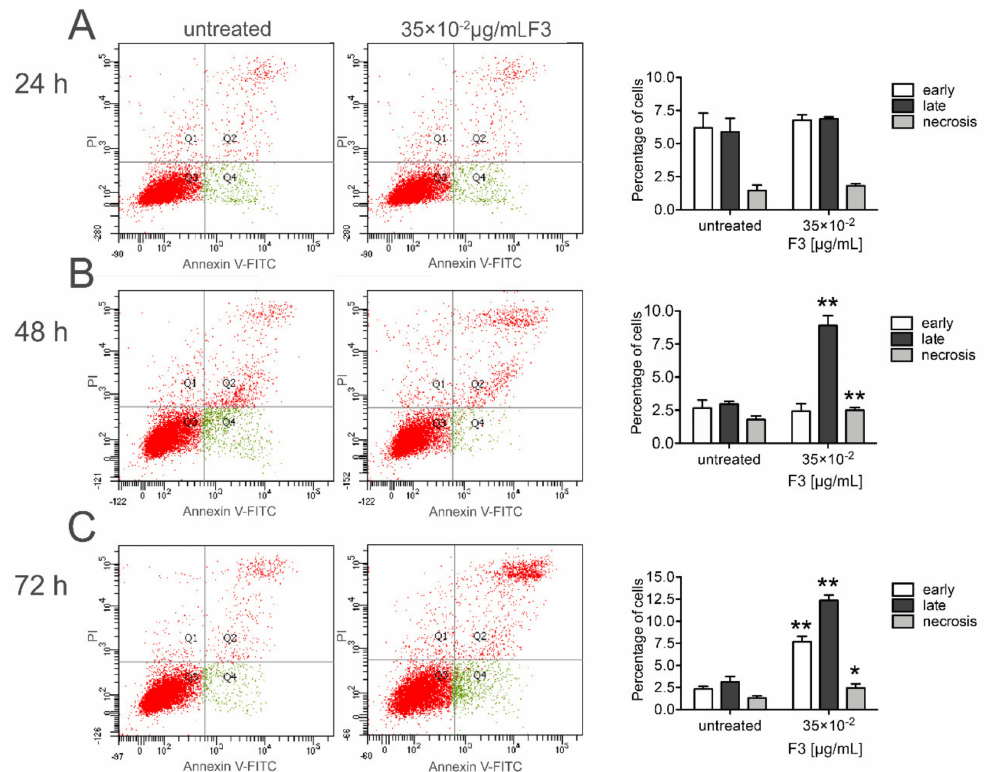
Figure 4. F3 treatment-induced apoptosis in DU 145 cells. The cells were exposed to 35 × 10 − 2 µ g / mL F3 for 24- ( A ), 48- ( B ) and 72 ( C ) h and apoptosis was analyzed by flow cytometry. The results are expressed as mean ± SD of three independent experiments * ( p < 0.05), ** ( p <